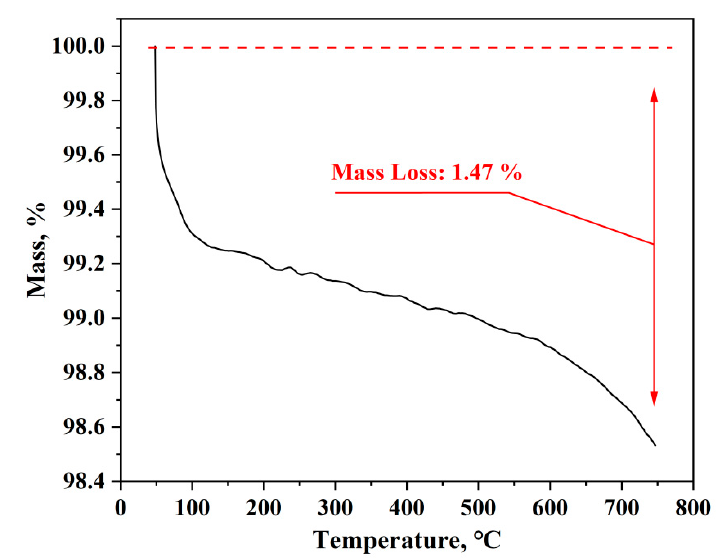
Figure 4. TG of UST-Sn-LS at a temperature ramping of 10 °C min − 1 from 50 to 750